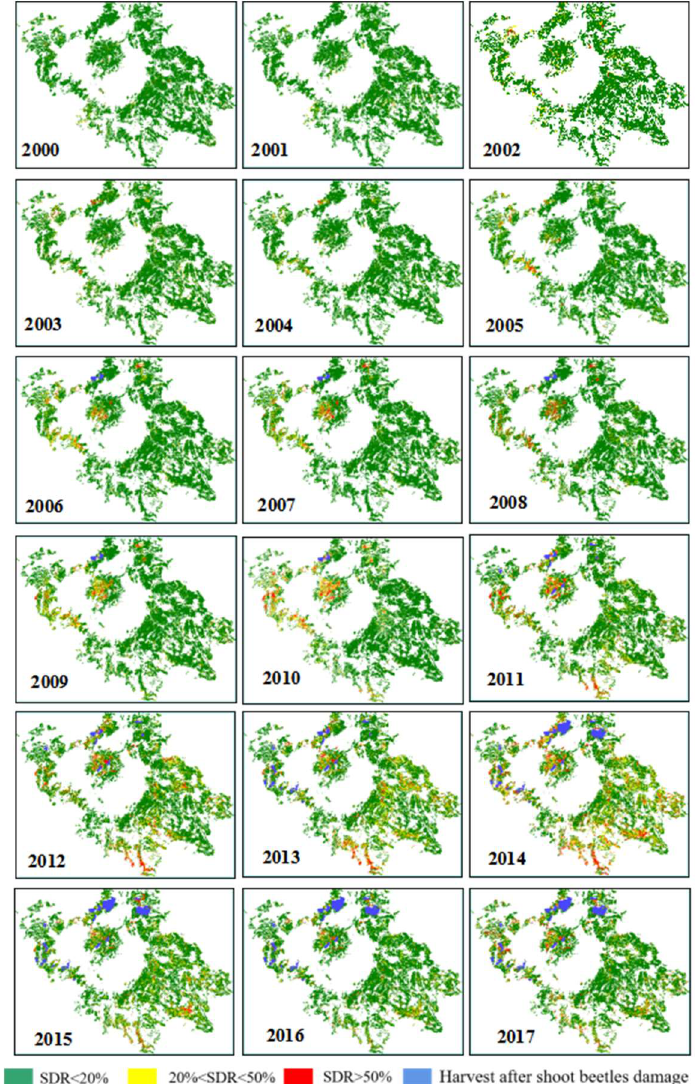
Figure 5. Time series of Yunnan pine forests with different shoot damage ratios in the study area from 2000 to 2017.